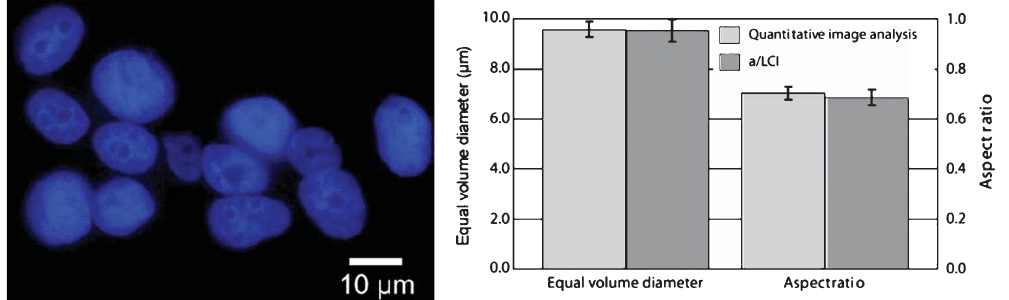
Fig.12. (Left)FluorescencemicroscopyimageofMCF7nucleiusingDAPI.Nucleiareapproximatelyspheroidalandrandomlyaligned.(Right) MeasurementsofequalvolumediameterandspheriodialaspectratiobyQIAusingDAPIstain,anda/LCIusinglivecells.Errorbarsarestandard error at 95% confidence. Adapted from